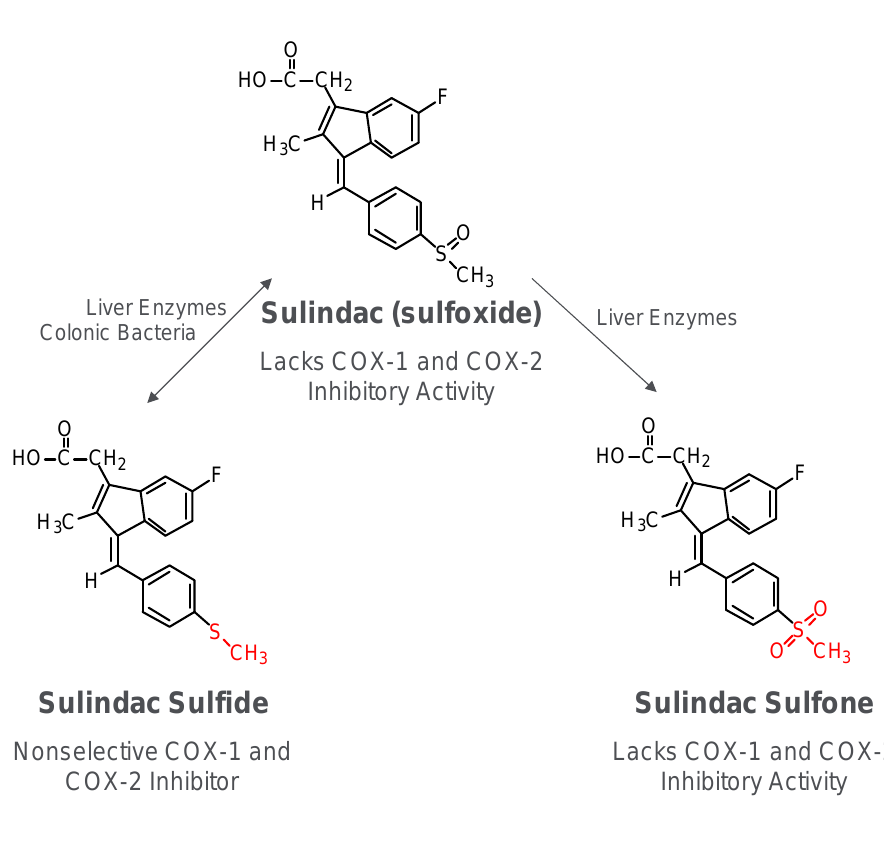
Figure 2. Metabolism of